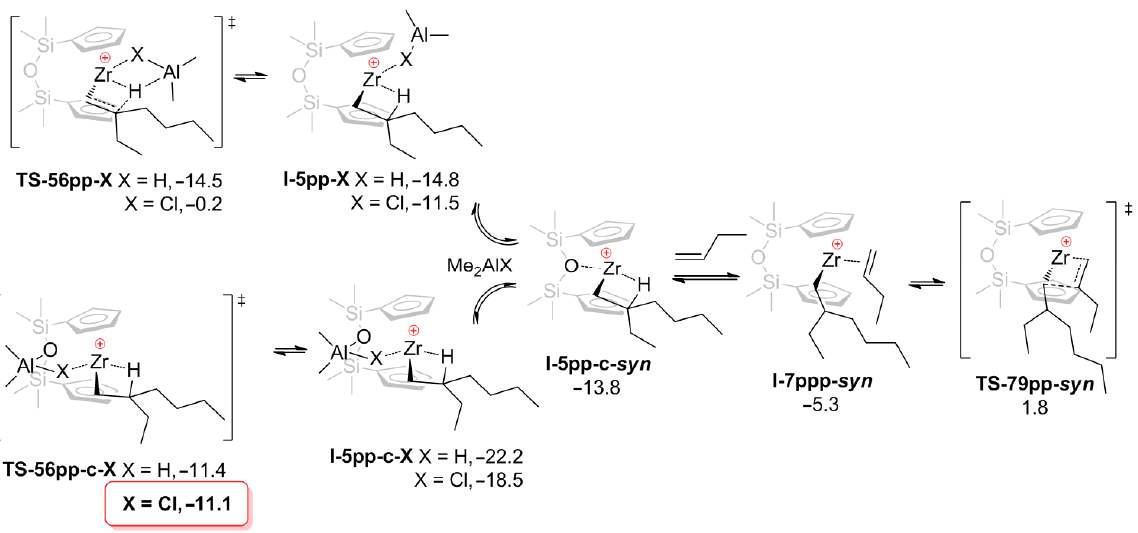
Figure 20. Transformations of O[SiMe 2 ( η 5 -C 5 H 4 )] 2 Zr–derived β -agostic complex I-5pp with the participation of Me 2 AlX species. The values of calculated free energies (kcal/mol) relative to I-2p β -c are given. Reprinted with permission from [42]. Copyright (2020) MDPI.